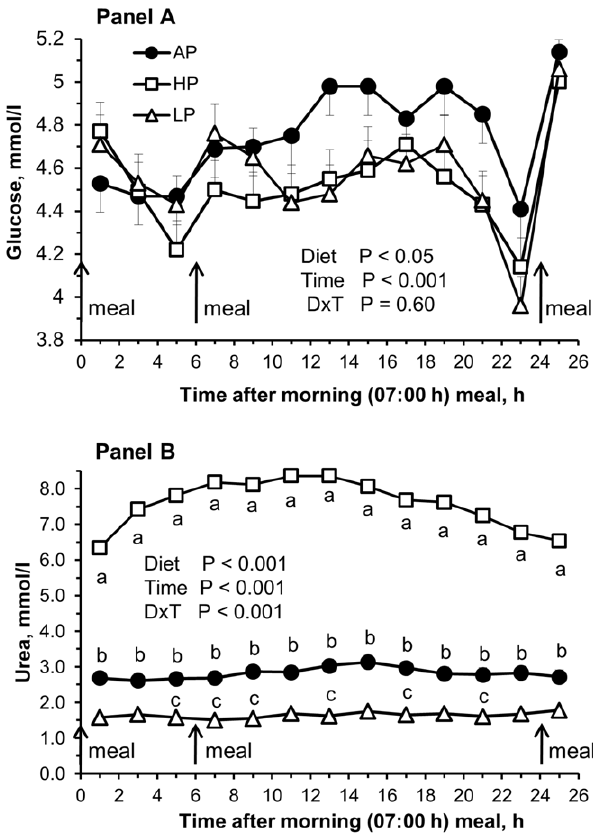
Figure 1. Diurnal plasma glucose and urea concentrations at 92 dpc. Diurnal plasma metabolite concentrations of sows at 92 dpc fed isoenergetic diets with low protein:high carbohydrate (LP; open triangles), adequate protein:carbohydrate (AP; closed circles), and high protein:low carbohydrate (HP; open squares) ratios throughout pregnancy. Values are depicted from one hour after feeding the morning meal (50% of the daily allowance at 07:00h) to the midday meal (13:00 h) until the next day one hour after morning meal (08:00 h). Panel A, glucose; panel B, urea; Values are least square means 6 SE, n=9 per group. Inserts depict P values for the main factors diet and time and interactions. a,b,c Within time points, values with different lower case letters indicate significant differences ( P , 0.05) between diet groups.